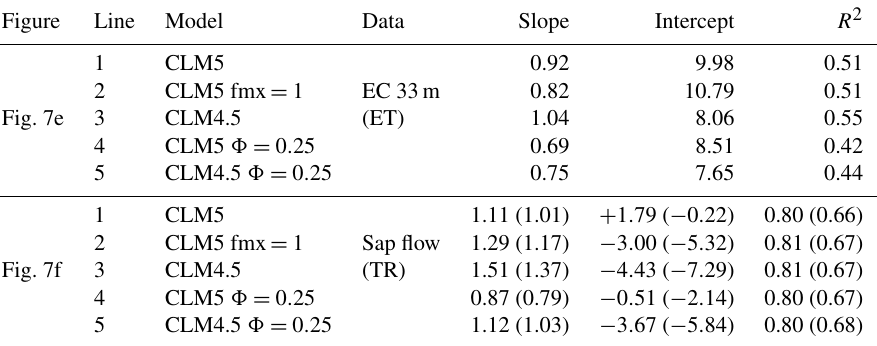
Figure 5. (a) Ensemble diurnal variation of the CO 2 flux: differences between eddy covariance (canopy tower 33m) and CLM in daytime are 6.7, 4.9, and 3.6µmolm − 2 s − 1 for CLM4.5, CLM5, and CLM5BGC, respectively. (b) Scatter plot using data shown in previous panel with one-to-one line noted (a) . (c) APAR vs. GPP, and w j is simulated with default parameters and C i = 0 . 667. (d) The light-limited model tested with different parameters. “Max” is the theoretical maximum, “Elv” is saturated–elevated conditions, “Amb” is normal atmosphere conditions, and “Fit” is a fitted value from our observations. In the legend, [ (cid:50) ] means the usage of the hyperbolic function in Eq. (7), like Elv[ (cid:50) ]. Without [ (cid:50) ], only the slope parameter is active as “Elv”. These parameters are described in full in Sects. 2.3 and 3.2. Table 1. Fitting parameters and regression coefficients for sap-flow and eddy-covariance measurements versus simulations by CLM at a daily scale for Fig. 7e and f. The nighttime data are excluded (set to zero) for both and values in parentheses are with nighttime data (intercept unit: 10 − 6 mms − 1